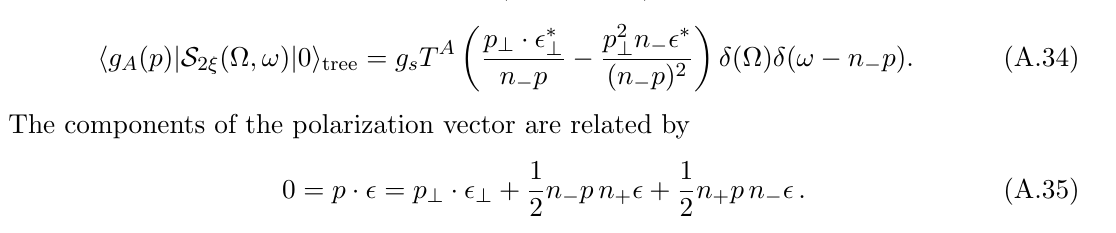
Figure 1 . Tree-level diagrams for the one-gluon matrix element of the soft operator part to the left (right) of the cut corresponds to the time-ordered (anti-time-ordered) part of the diagram, and lines labeled by n (cid:6) with in (out)-going arrow correspond to soft Wilson lines Y (cid:7) ( Y y The (cid:12)lled square and the two solid lines connected to it stand for the soft covariant derivative and the Wilson lines contained in i@ ? (cid:22)